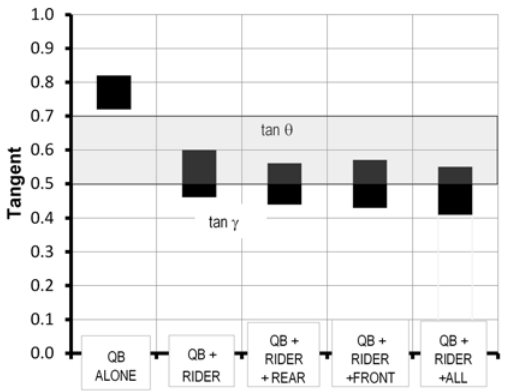
Figure 3. Static lateral instability angles (shown as tan γ ) for the eight work QBs, and a range of typical lateral traction coefficients (tan θ , assumed equal to the longitudinal values shown in Figure 1) for tyres on agricultural soils.